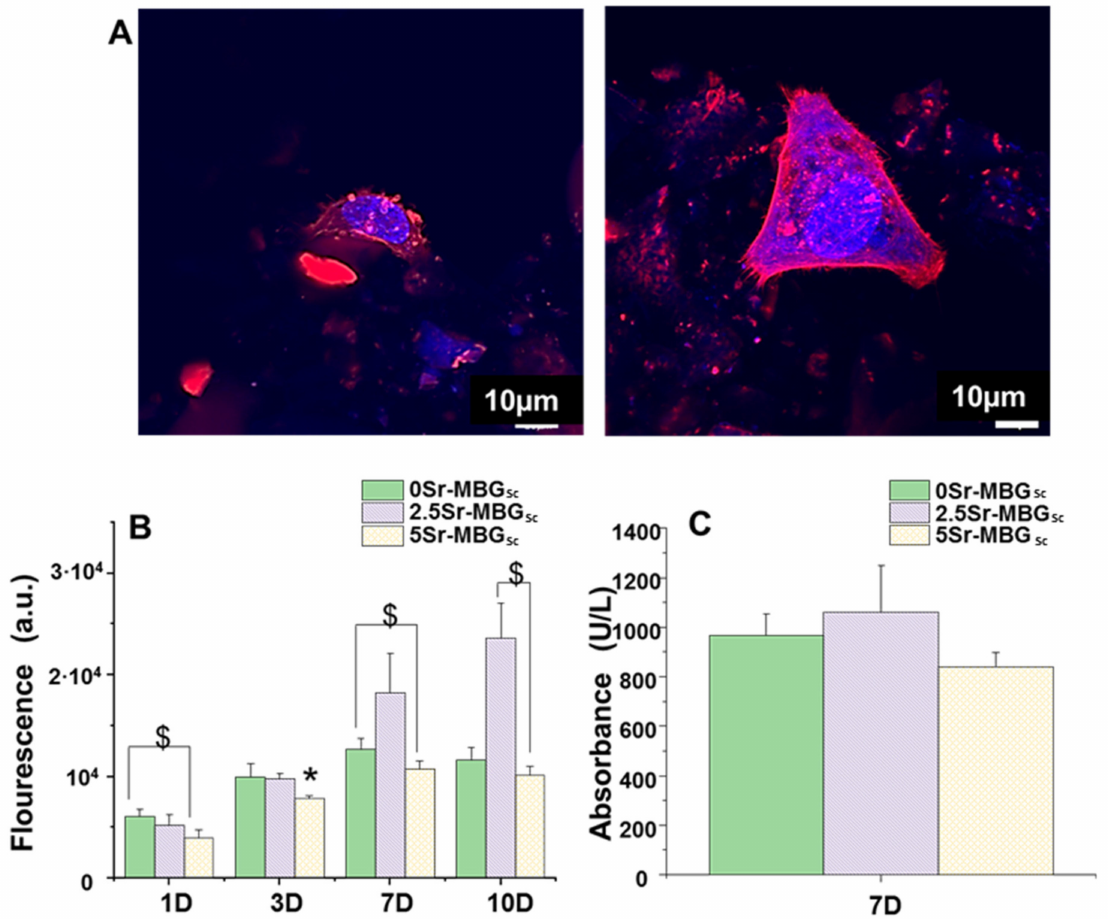
Figure 8. ( A ) MC3T3-E1 cells cultured inside the 2.5Sr-MBG sca ff old after 24 h were observed with confocal microscopy. Atto 565–phalloidin staining the F-actin microfilaments was used to visualize the cell cytoskeleton (red) and DAPI cell nuclei (blue). ( B ) Proliferation of MC3T3-E1 cells as a function of culture time on the di ff erent MBGs sca ff olds at 1, 3, 7 and 10 d. ( C ) Lactate dehydrogenase (LDH) of MC3T3-E1 cells in the presence of the MBG sca ff olds after 7 d of cell culture. ($) Significant di ff erences between designated samples ( p < 0.05), and. (*) Significant di ff erences are shown comparing the indicated sample with the others ( p <